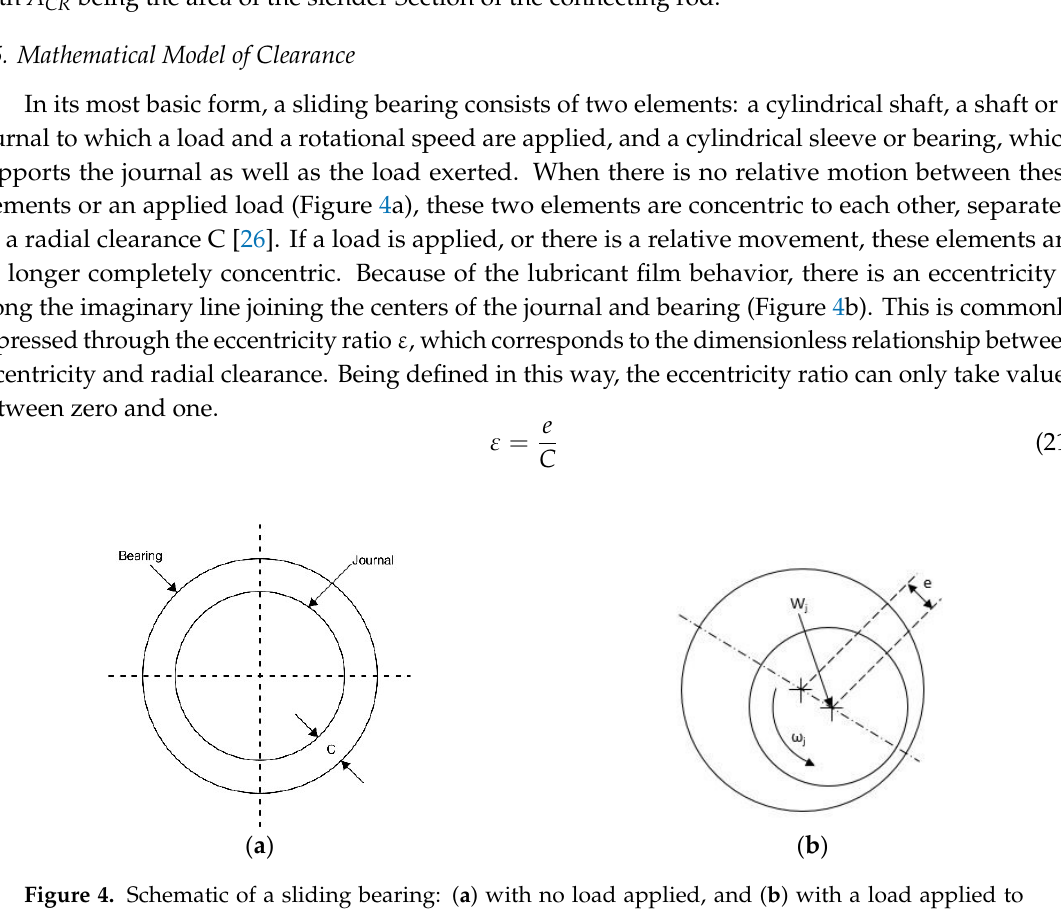
Figure 4. Schematic of a sliding bearing: ( a ) with no load applied, and ( b ) with a load applied to the journal.